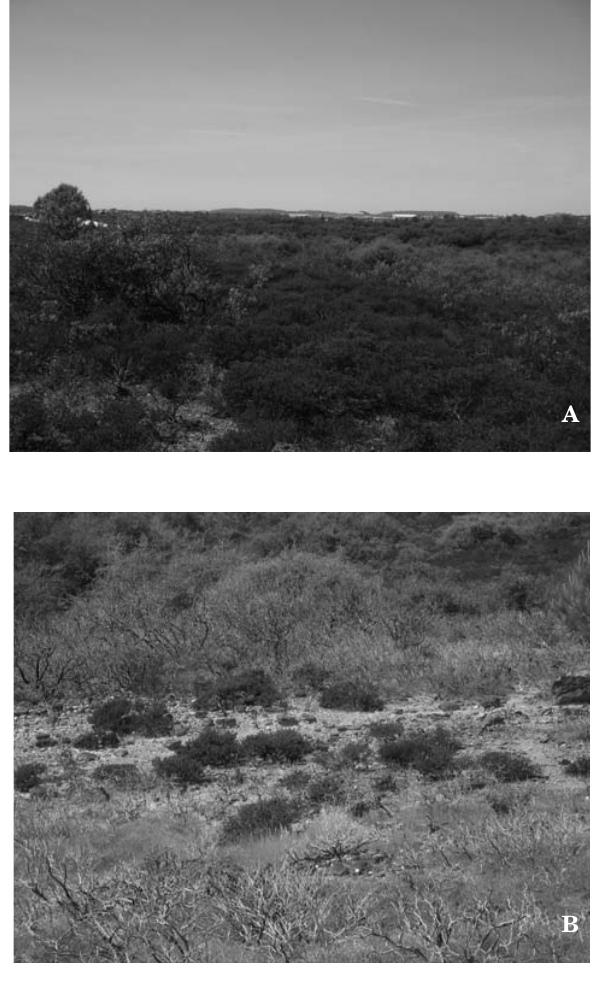
Fig. 3. A. An healthy stand of Ione manzanita ( Arcto- staphylos myrtifolia ) in the Sierra Nevada of